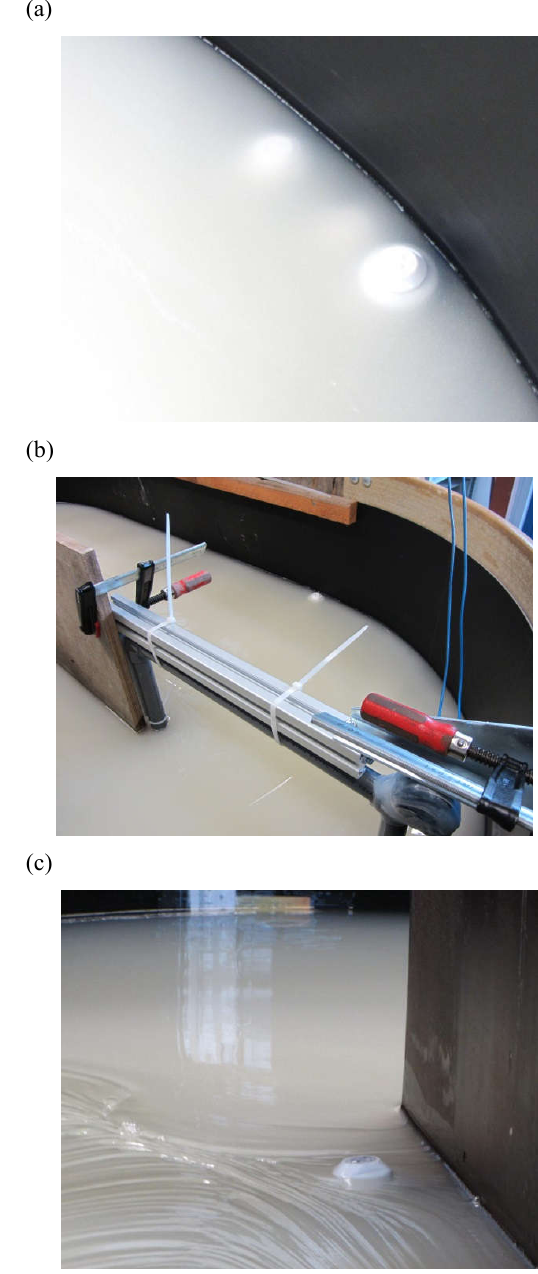
Figure 8. Floating sensor particles at different positions on the liq- uid surface in the biogas digester.